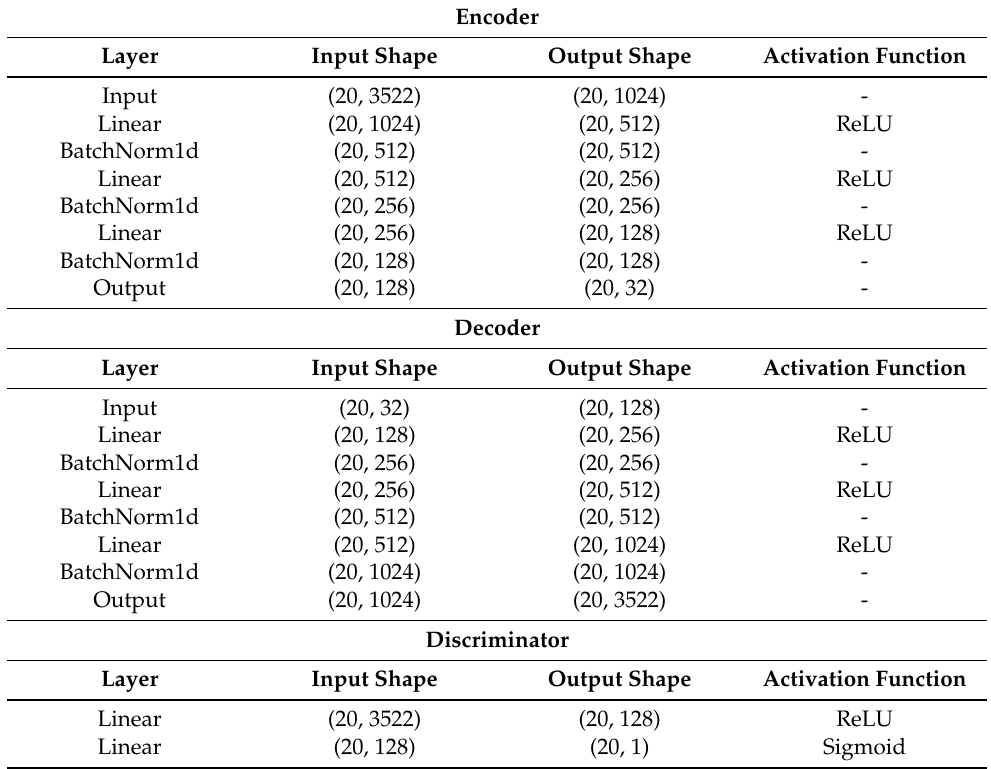
Table 1. Parameters of